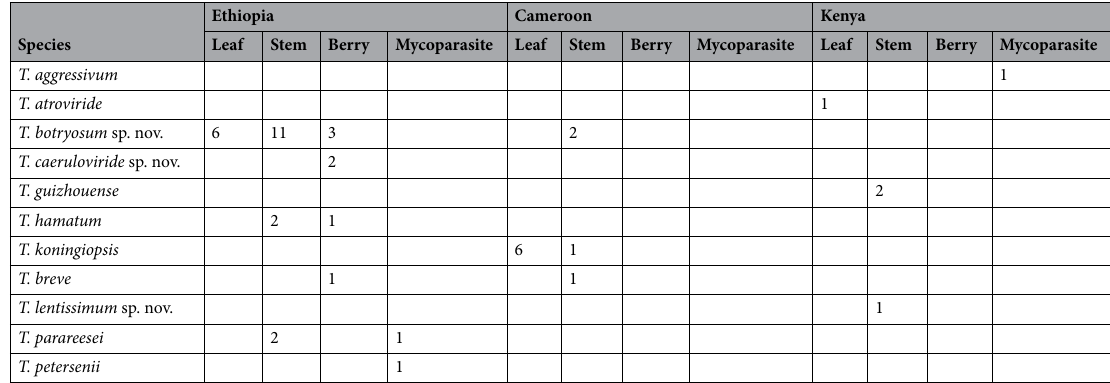
Table 2. Number of taxa collected in this survey per country-source.